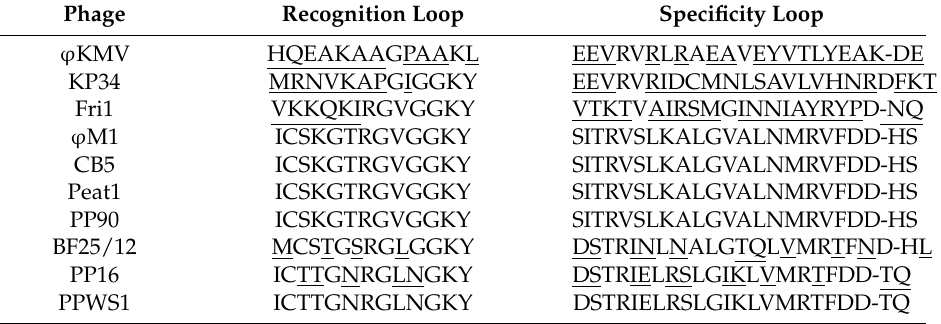
Table 4. Alignment of the recognition and specificity loops of the RNAP of PhiM1-like phages to phages ϕ KMV and KP34. Underlined amino acids/residues show sites of substitutions in comparison to ϕ M1. Phage Recognition